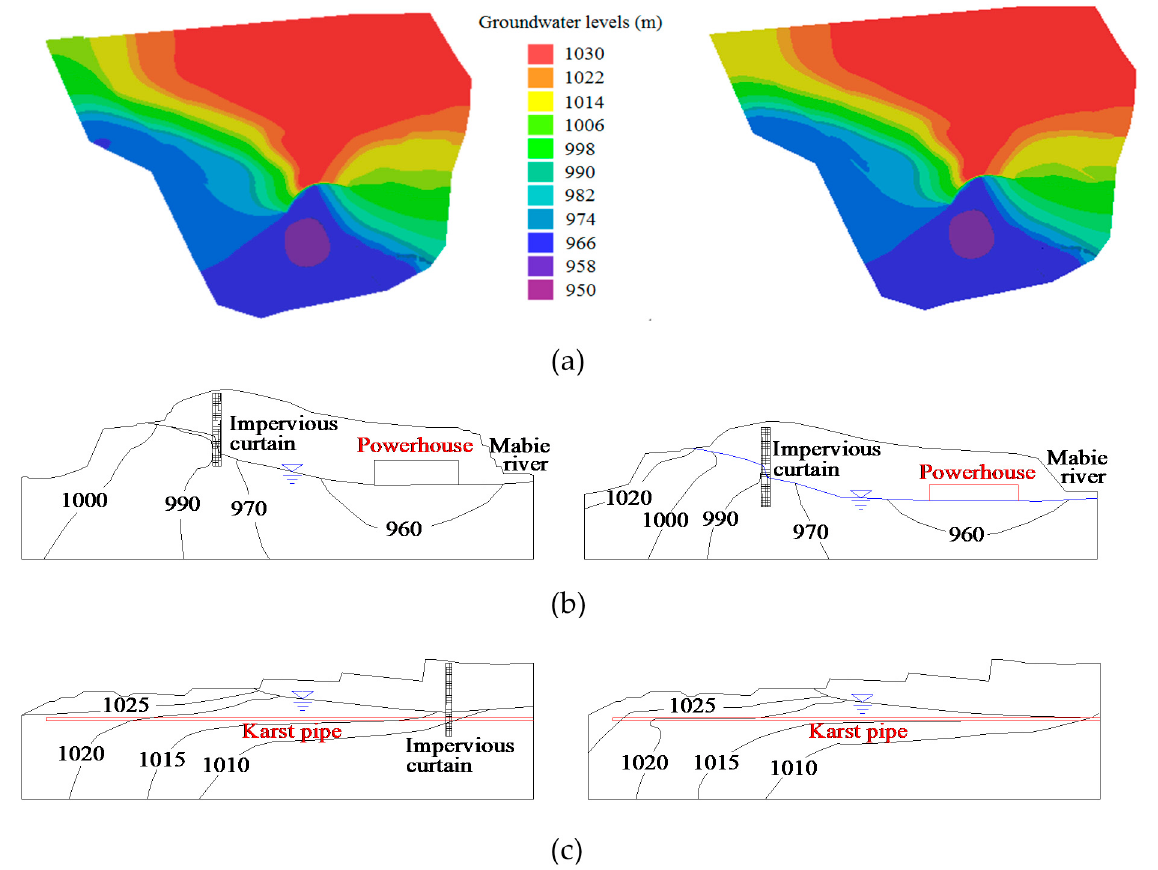
Figure 9. Contour maps of groundwater level for karst pipes with and without the impervious curtain (( a ) planar maps with an elevation of 950 m, ( b ) cross sections of underground powerhouse, and ( c ) cross sections of No. 4 karst pipe).